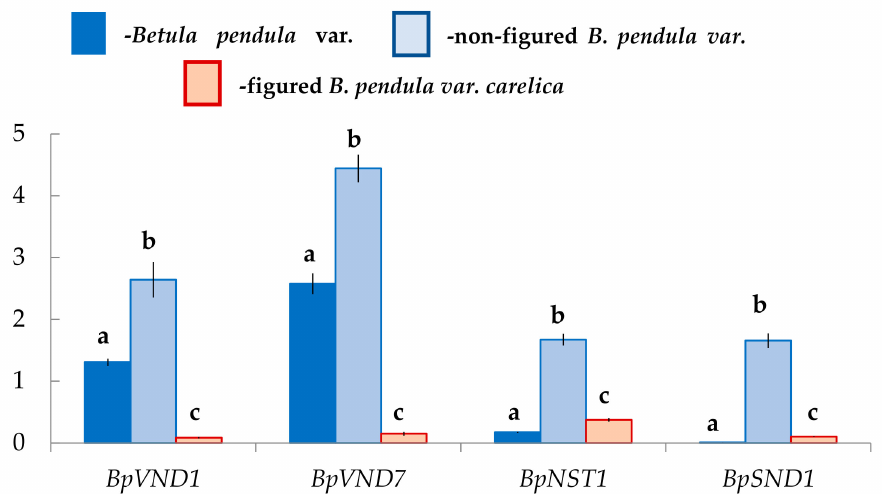
Figure 8. Relative expression (arbitrary units) of genes with the NAC domain in the xylem of B . pendula var. pendula , non-figured and figured B. pendula var. carelica trees. Samples were collected on 25 June 2019. Different letters indicate significant differences at p -value < 0.05. Bars are means of n experimental runs ± SD according to Mann–Whitney U-test. n = 6.